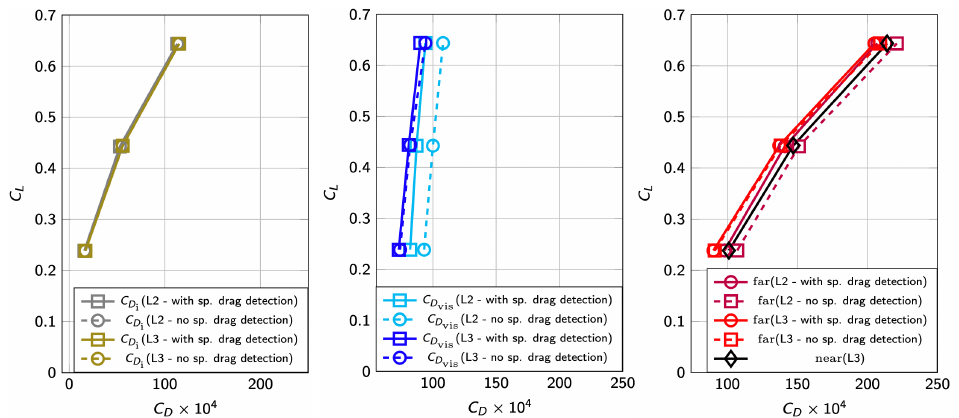
Figure 20. OFF configuration at Re ∞ = 16.6 × 10 6 , M ∞ = 0.480. Breakdown of the drag polars with and without spurious drag detection on medium and fine mesh levels; induced drag computed by Maskell’s